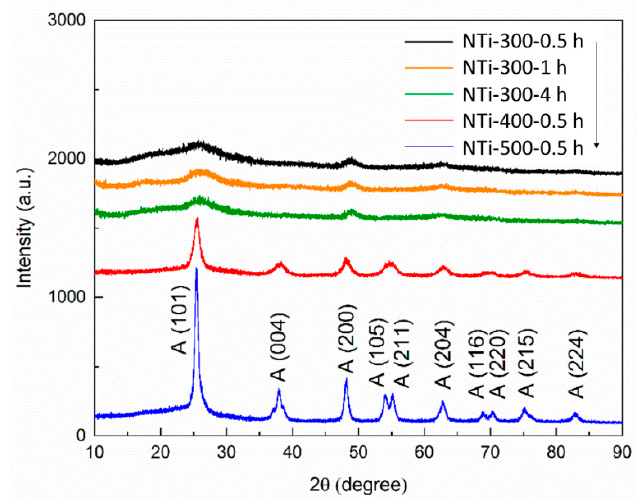
Figure 2. The pXRD spectra of the N-TiO 2 photocatalysts. Black: NTi-300-0.5 h, Orange: NTi-300-1 h, Green: NTi-300-4 h, Red: NTi-400-0.5 h, Blue: NTi-500-0.5 h.